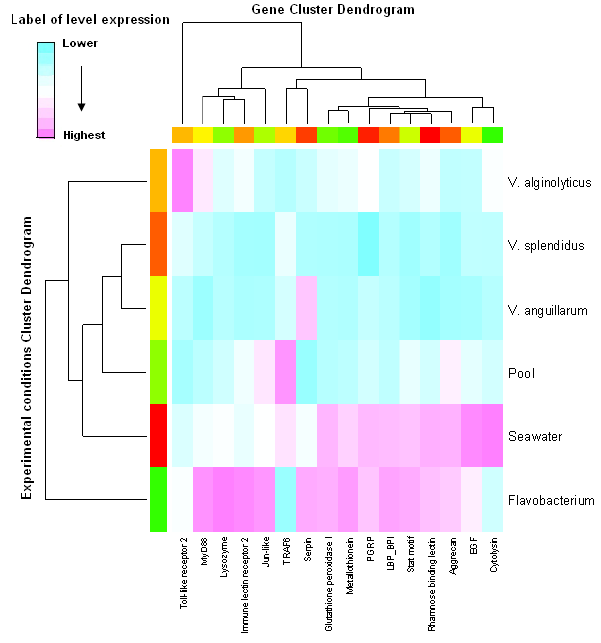
Fig. 6 Fig. 6. Hierarchical Clustering Heatmap Plot of dendrograms using Unweighted Pair Group Method with Arithmetic Mean (UPGMA) method. The heatmap represents a grid of coloured points where each colour represents a level of gene expression (Fold change). The rows represent Experimental conditions ( V. alginolyticus , V. splen- didus , V. anguillarum , pool of Vibrios, Seawater and Flavobac- terium ) and the columns represent 16 genes analysed at 12h of in- fections. The grid coordinates correspond to the sample by gene combinations where the dark pink colour corresponds the highest expression and dark blue corresponds to the lowest